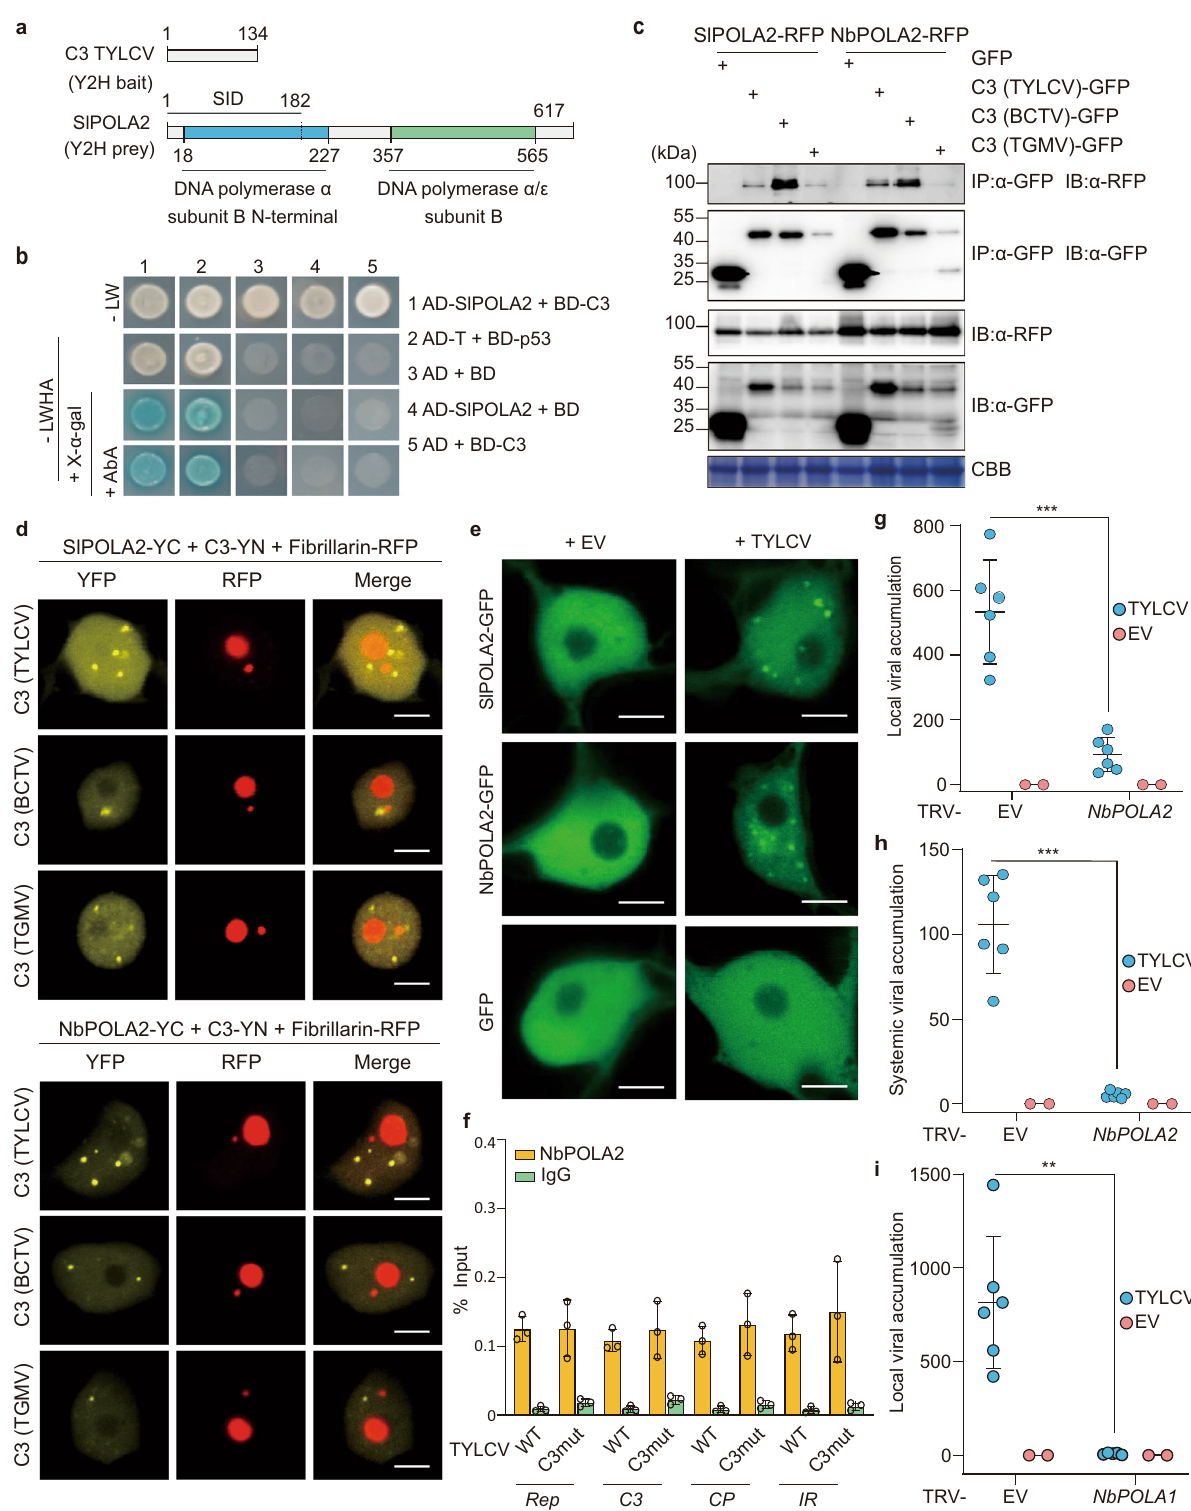
NbPOLD2 (Fig. 2d, e). With the aim to decipher whether DNA polymerase α acts in concert with DNA polymerases δ and/or ε in the replication of the viral DNA, we silenced the corresponding regulatory subunits POLD2 and POLE2/DPB2 by VIGS in N. benthamiana , and tested the capacity of TYLCV to replicate in local infection assays and to infect systemically. Silencing of either subunit results in a distinct developmental phenotype, with plants NATURE COMMUNICATIONS| (2021) 12:2780